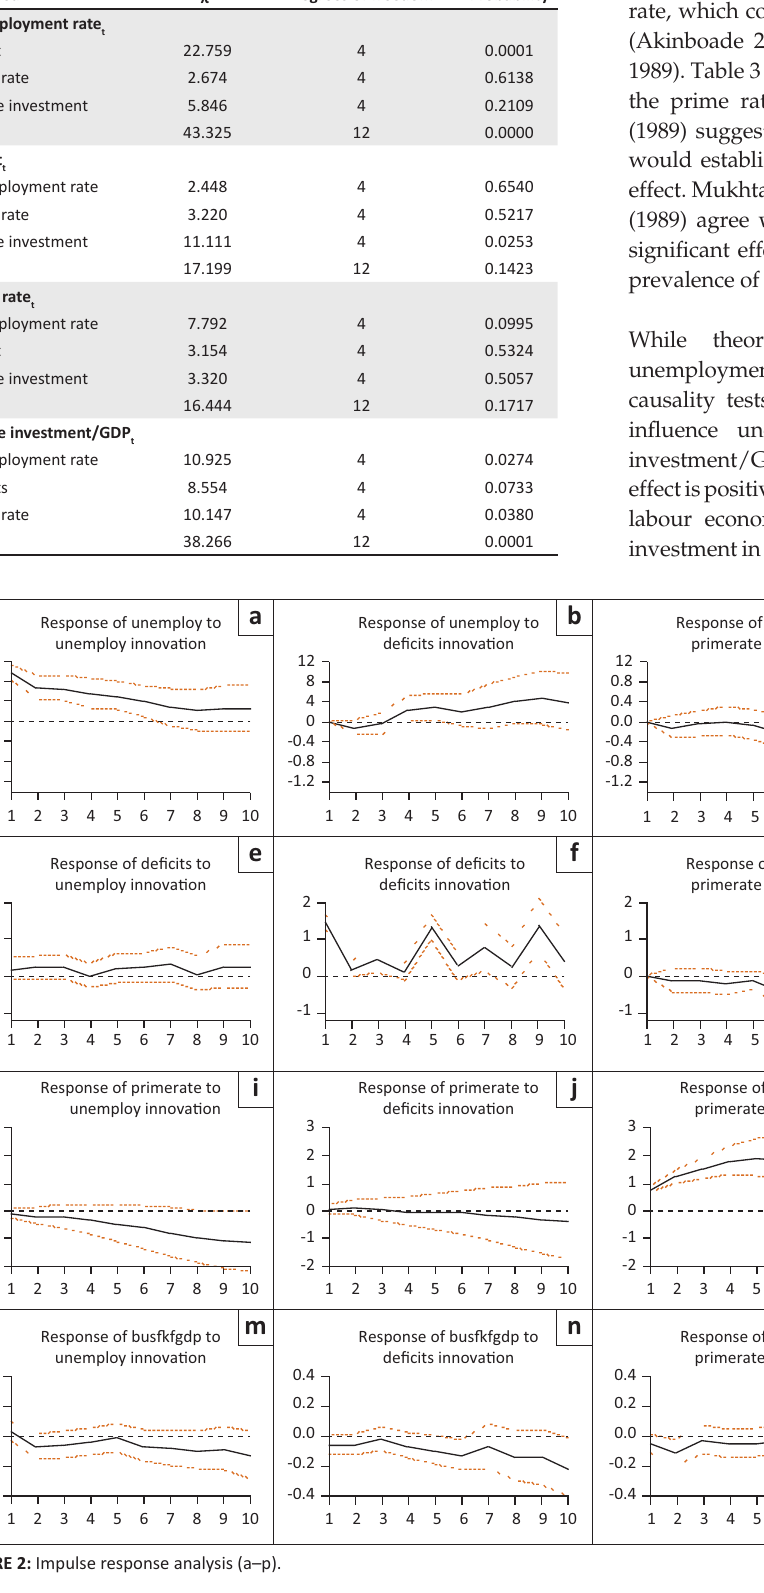
outcomes in Figure 2 also confirm that a one standard deviation